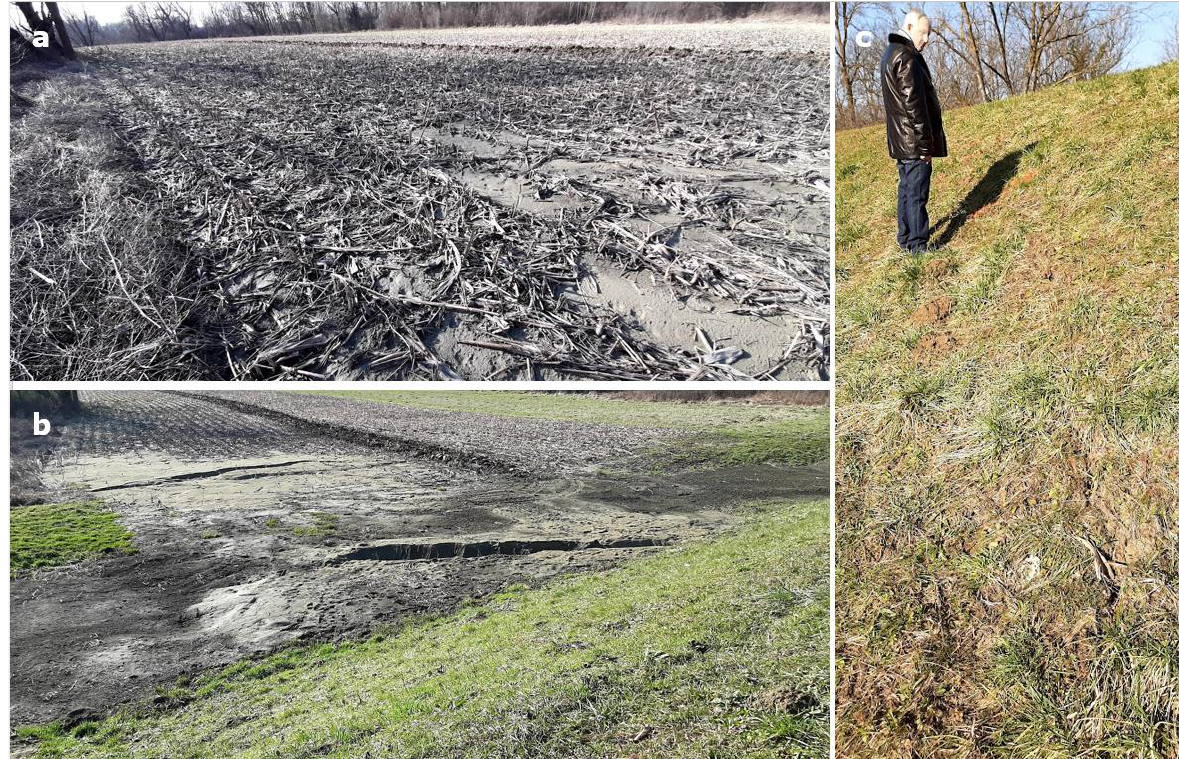
Figure 10. Embankment and surroundings near Hrastelnica ( a ). The ejecta were found on both sides of the embankment, the river side is shown here ( b ). The crack on the embankment ( c ) is barely visible4. Rationale for the